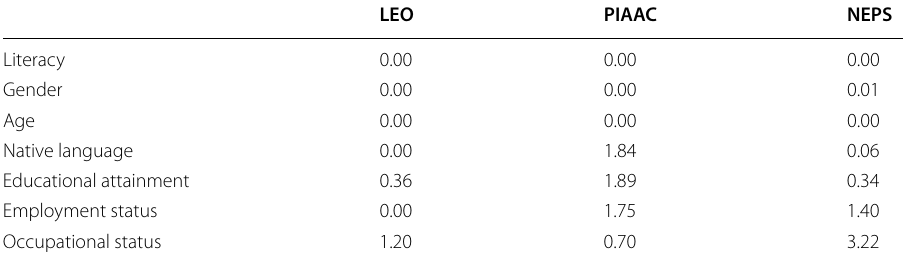
Table 8 Proportion of missing values for analytic samples of LEO, PIAAC, and NEPS in %